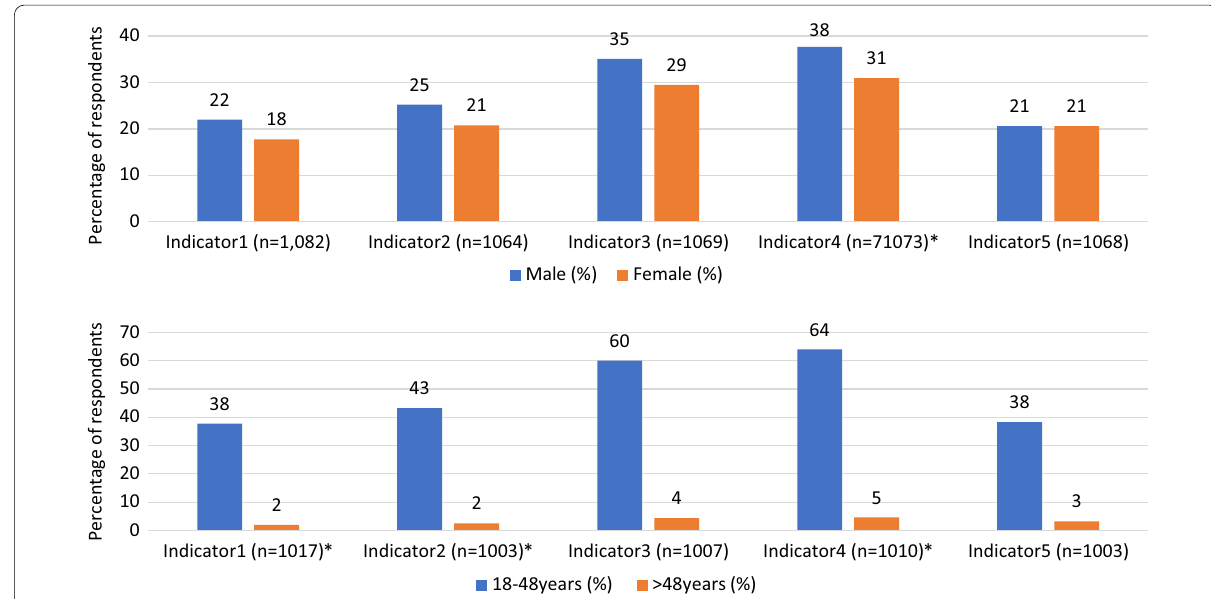
Fig. 1 Perceptions on COVID‑19 vaccination: disaggregated by gender and age. Source: (Field Data, 2020); Legend: Indicator1 (Participate in COVID‑19 vaccine trial); Indicator2 (Advise someone to participate in COVID‑19 vaccine trial); Indicator3 (Accept/take vaccination for COVID‑19); Indicator4 (Advise someone to accept/take COVID‑19 vaccination); Indicator5 (Willingness to pay for COVID‑19 vaccination); *Chi‑square